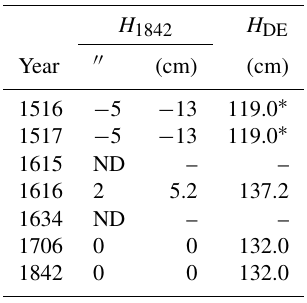
Table 5. Marks on a hunger stone in Dolní Žleb surveyed in 1842 (Protokoll, 1842).